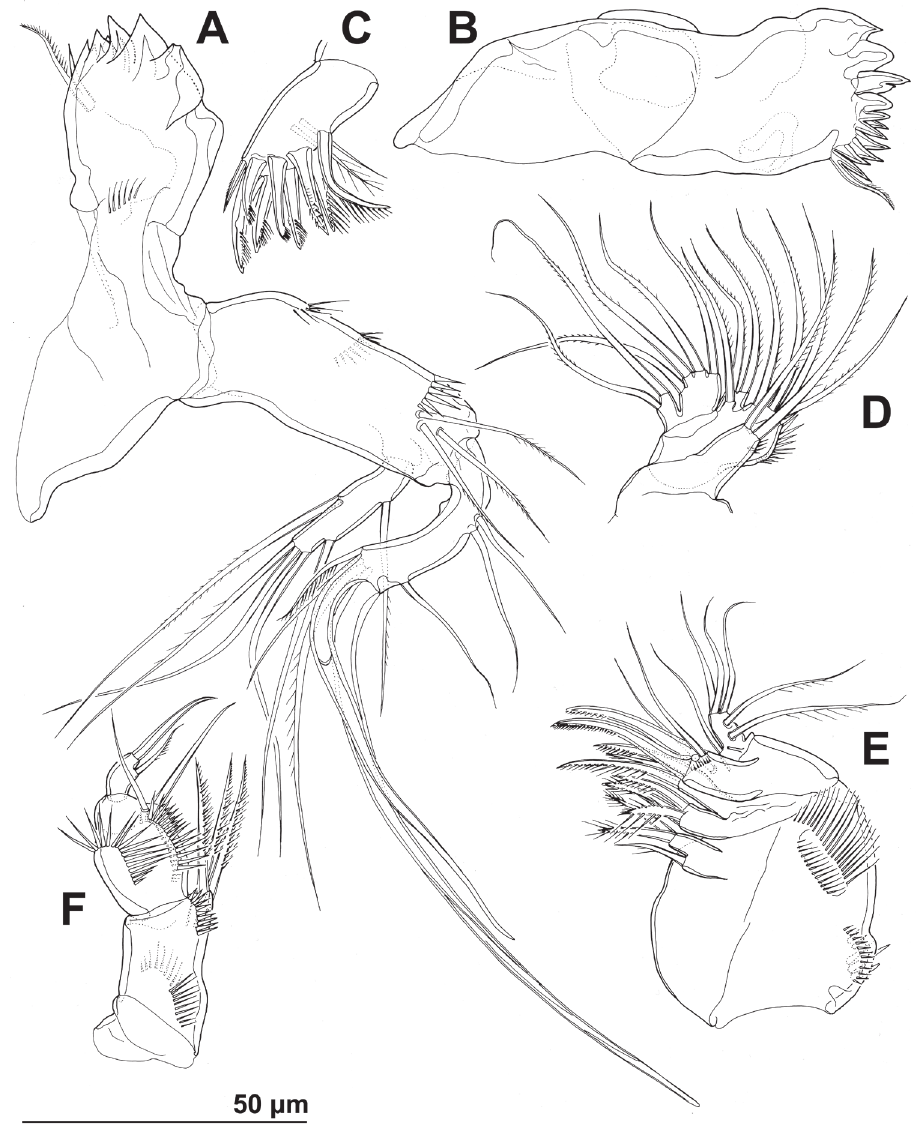
Figure 4. Stenhelia pubescens Chislenko, 1978, line drawings, female 3: A mandibula, posterior B man- dibular coxa, anterior C maxillula, praecoxa arthrite, posterior D maxilular palp, posterior E maxilla, anterior F maxilliped,